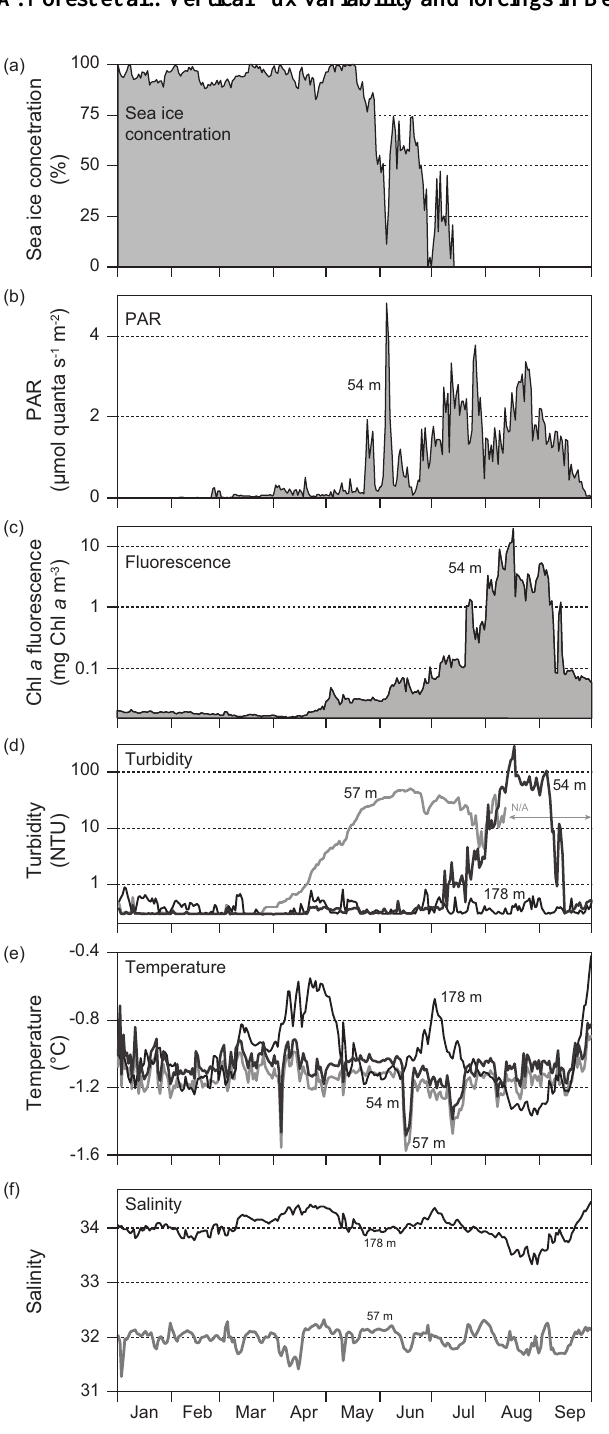
Fig. 4. Time series from January to September 2009 at mooring CA05 of (a) ice concentration (12.5 × 12.5km pixel over the moor- ing); (b) photosynthetically active radiation at ∼ 54m; (c) chloro- phyll a fluorescence at 54m; (d) turbidity at 54, 57, and 178m (measured with three different types of sensor; see Sect. 2.4 for de- tails); (e) temperature at 54, 57, and 178m; and (f) salinity at 57 and 178m. These variables aim at showing the general seasonality of the pelagic environment in southeast Beaufort Sea prior to the 2009 ArcticNet-Malina field campaign. N/A: no data available.